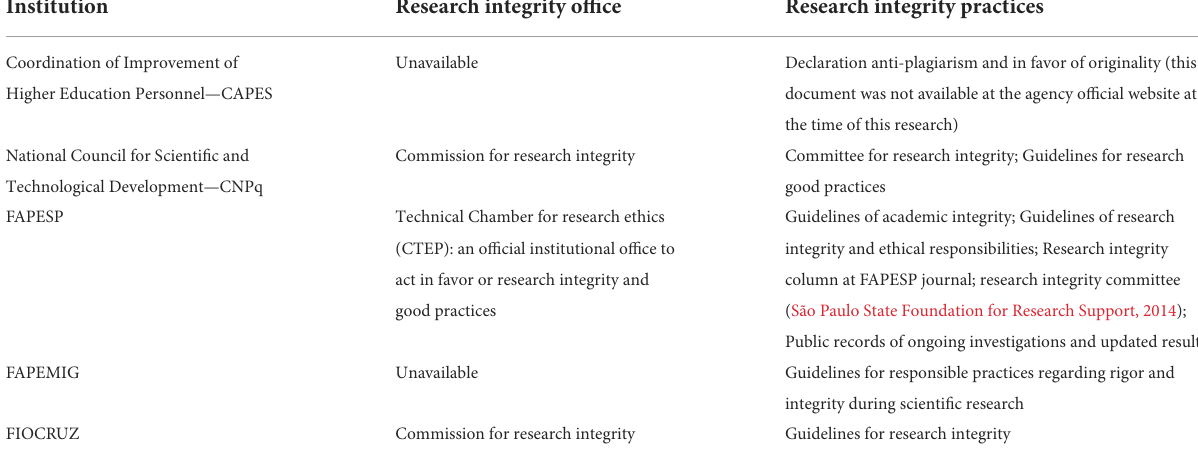
TABLE 1 Main Brazilian funding institutions and research integrity policies.